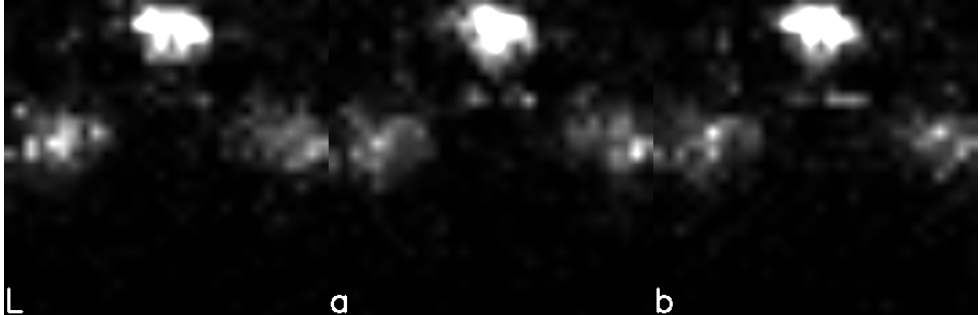
Figure 6. Visualization of the learned weights in image format (white color important, black less im-